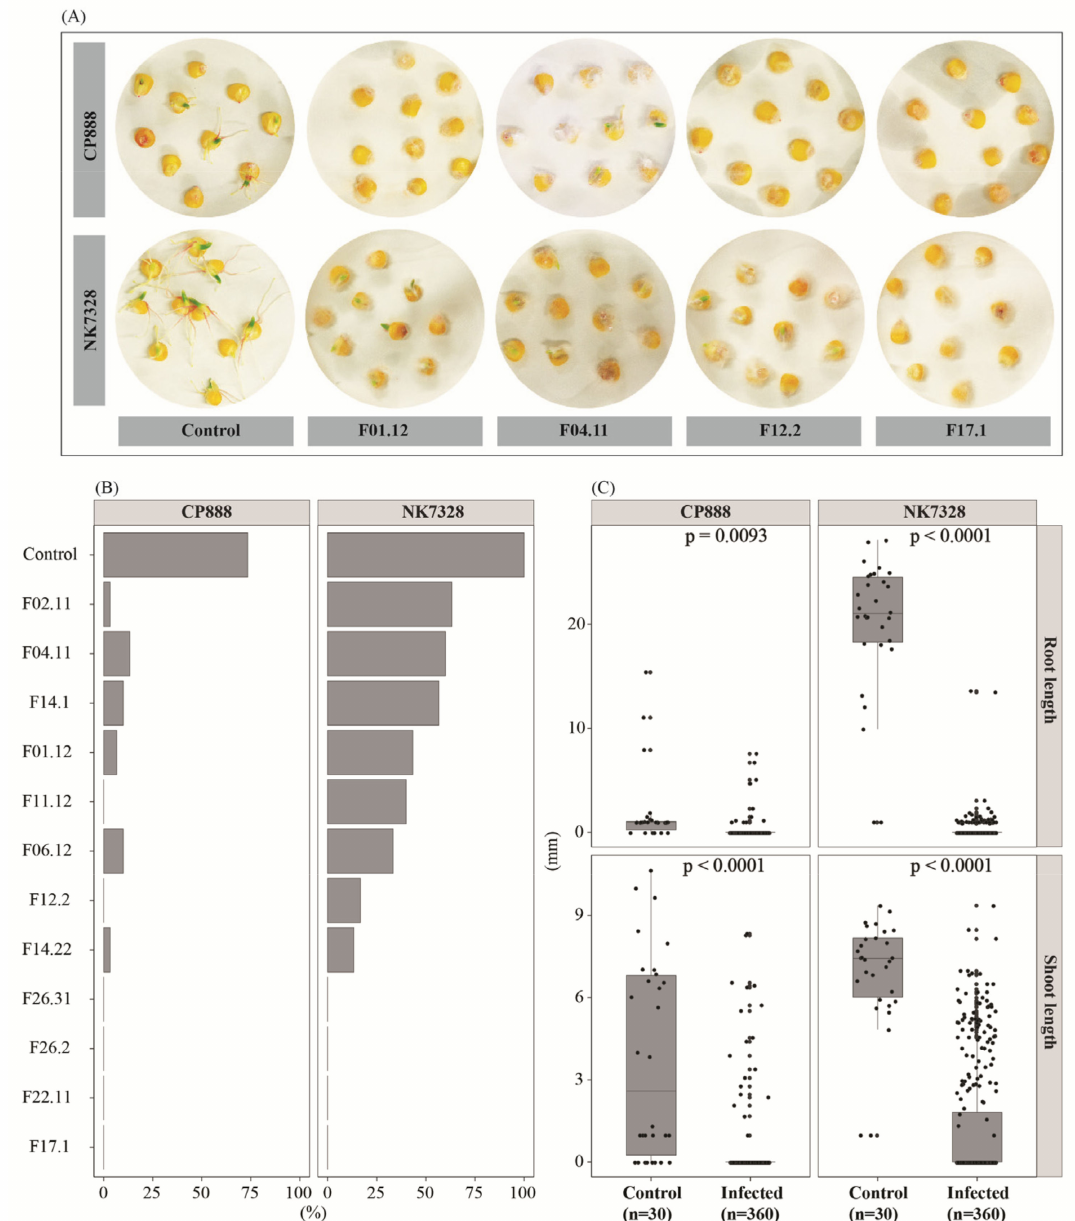
Figure 1. ( A ) Germination of seeds on moistened Whatman papers by treatments. ( B ) Germination rates (%) of CP888 and Bt/GT NK7328 seeds when infected with each Fusarium verticillioides isolate at 7 days after inoculation. Thirty seeds were infected with each isolate at a concentration of 10 7 conidia mL − 1 , while sterile water was utilized for a control treatment. ( C ) Impacts on root length and shoot length upon infection by pathogens. Statistical differences were interpreted using a Student’s t -test at a significant value of α =